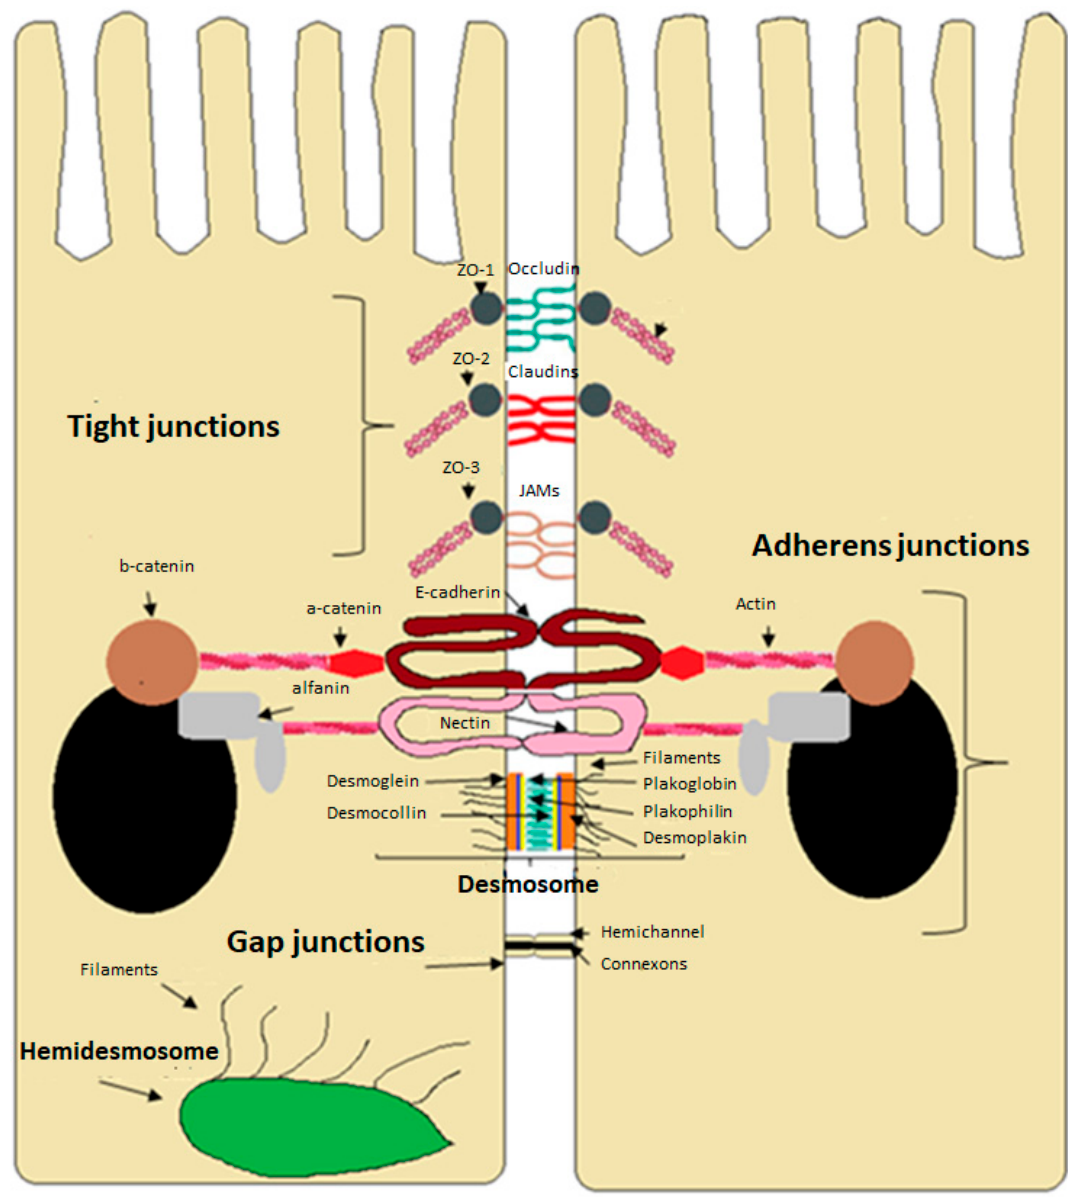
Figure 4. Intercellular junctions of the intestinal epithelium. Adherent junctions regulate adhesion between adjacent cells through transmem- brane adhesion molecules of the catenins and protein complexes associated with the actin cytoskeleton. The AJs are located on the lateral membrane below the TJs and are necessary to assemble and maintain tight joints. E-cadherin is among the isoforms of cadherin in epithelial tissues and participates in cellular processes, cell proliferation, the establish- ment of cell polarity, and remodeling of the actin cytoskeleton [26]. Desmosomes are in- tercellular junctions composed of desmocolins, desmoglein, and cadherins. These inter- cellular junctions can also act as intracellular signaling mediums [26]. Gap junctions are made up of six transmembrane proteins called connexins. They allow communication be- tween cells, performing an essential function in the development, growth and differenti- ation of epithelial cells [12].